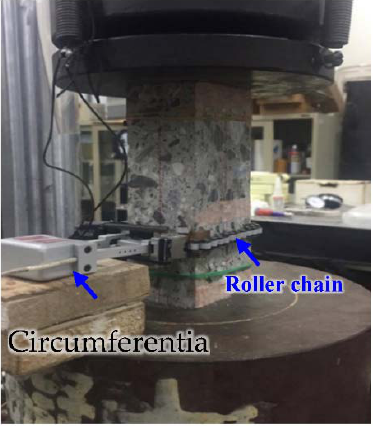
Figure 2. Uniaxial Compressive test with a circumferential extensometer.